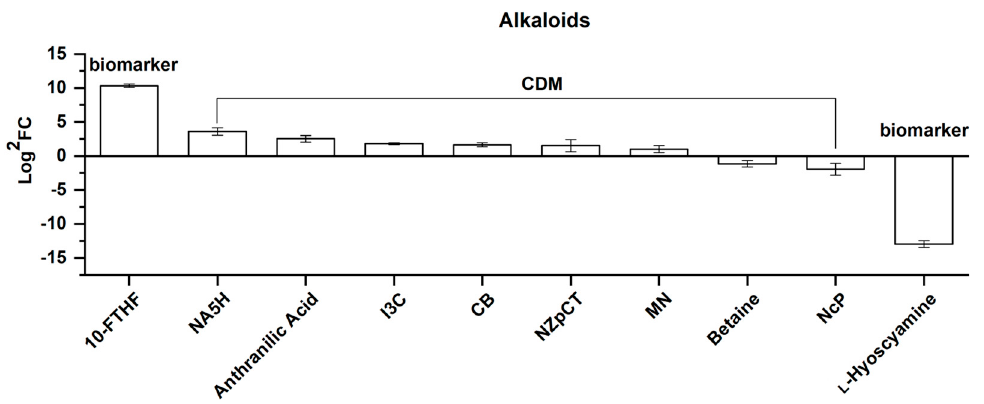
Figure 13. Comparison of alkaloids, consisting of 2 biomarkers and 8 CDMs between SJL and SN. Upregulation denotes that the content of a metabolite increased in SN compared with that in SJL, and the opposite for downregulation. The Y -axis is exhibited as Log 2 FC values for the convenience of visual presentation. The X -axis denotes the metabolite names. Abbreviation: 10-FTHF, 10-formyl-THF; NA5H, N -acetyl-5-hydroxytryptamine; I3C, indole-3-carboxaldehyde; CB, cocamidopropyl betaine; NZpCT, N - Z - p -coumaroyl-tyramine; MN, methyl nicotinate; NcP, N - cis -paprazine.